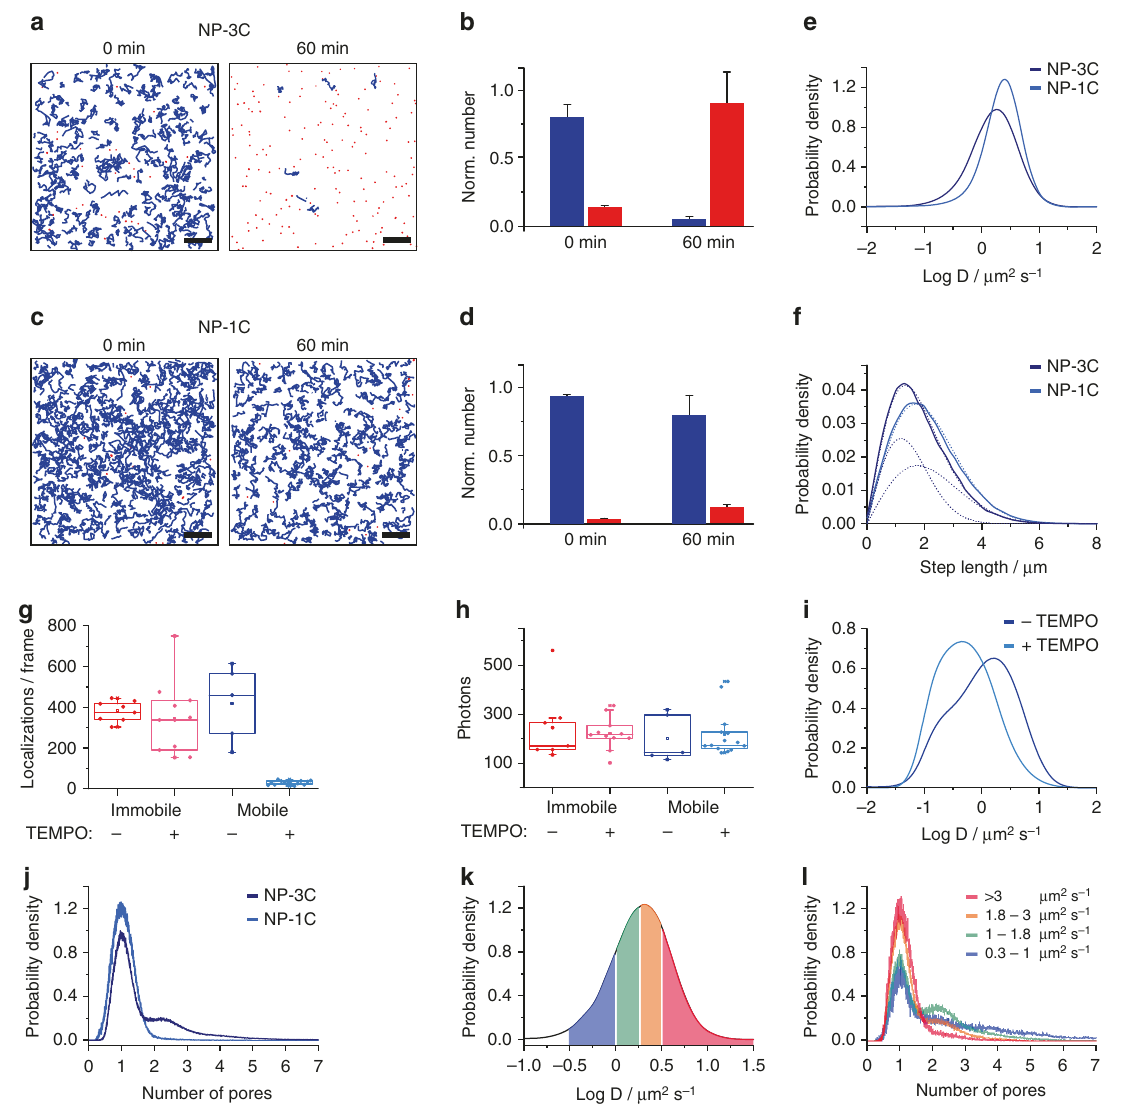
Fig. 3 Single-molecule analysis of NP-1C and NP-3C mobility in PSM. a − d Time-dependent changes in nanopore mobility quanti fi ed by single-molecule analysis of NP-3C ( a , b ) compared to NP-1C ( c , d ). a , c Trajectory maps of mobile (blue) and immobile (red) AF647 NP-3C ( a ) and AF647 NP-1C ( c ) molecules at time points of 0 min (left) and after 60 min (right). Scale bars: 5 µ m. b , d Quanti fi cation of the relative fraction of mobile and immobile NPs for AF647 NP-3C ( b ) and AF647 NP-1C ( d ) between both time points (mean and s.d. of n = 3 – 5 experiments). e Probability density function (pdf) for the diffusion coef fi cient of AF647 NP-1C and AF647 NP-3C trajectories at 0 min ( n = 6800 and 3900 trajectories over ten frames long, respectively). f Step length distribution diagram (30 frames, 19 ms) of AF647 NP-1C and AF647 NP-3C and fi t by a two-component Rayleigh model (dashed lines) of the same data set. g Number of mobile and immobile fl uorescin-labeled NP-3C ( FAM NP-3C) detected in each frame before and after addition of (2,2,6,6-tetramethylpiperidin-1- yl)oxyl (TEMPO). h Integrated intensity of detected molecules before and after addition of TEMPO. Each datapoint in g , h corresponds to a separate experiment ( n ≥ 3). i Diffusion coef fi cients of mobile FAM NP-3C after addition of TEMPO (light blue) compared to the initial condition (dark blue). The distributions are based on n = 2000 and 3900 trajectories with a minimum of fi ve frames, respectively. j Intensity distribution determined from AF647 NP- 1C (light blue) and AF647 NP-3C (dark blue) trajectories normalized to single fl uorophore intensities. k Distribution of the NP-3C diffusion coef fi cients. Individual photon traces of the color-coded regimes were extracted and separately analyzed by their fl uorescence intensity like described for j . l Resulting probability density functions of the extracted diffusion regimes described in k in the same color-coding. The analysis in j and its subsets in k , l rely on 8800 and 19,700 trajectories ( > 10 steps) of AF647 NP-1C and AF647 NP-3C, Membrane perforation by DNA NP is rate-limiting . Single- combination with a spatiotemporal identi fi cation algorithm 35 established that more than 80% of AF647 NP-3C exhibited free molecule imaging of AF647 NP-3C revealed time-dependent changes in its diffusion behavior, suggesting a re-orientation Brownian motion as judged from a linear mean square dis- into a membrane-spanning state (Fig. 1d). In the fi rst minutes placement (MSD) diagram (Supplementary Fig. 3). However, 1 h after addition of AF647 NP-3C, individual NPs were largely lat- after NP-3C binding to the membrane, the mobility drastically erally mobile as implied by the motion blur, even though some decreased to more than 80% stationary signals (Fig. 3a, b and brighter spots suggested immobile NPs (Fig. 2c and Supple- Supplementary Movie 2). This fraction likely represents immobile mentary Movie 2). Quanti fi cation by single-molecule tracking in membrane-spanning pores that interact with the polymer layer